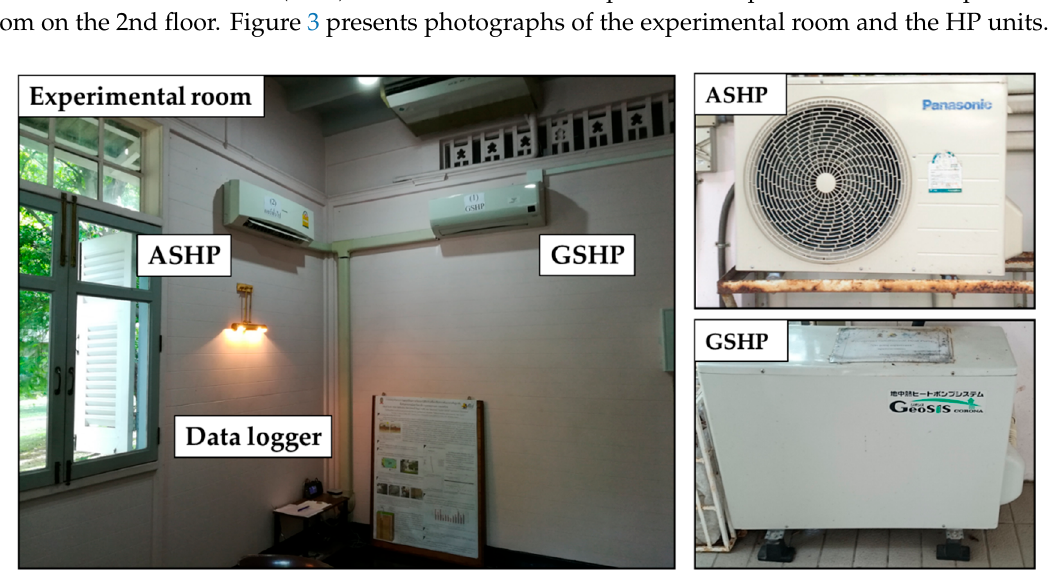
Figure 3. Photographs of the experimental room and the HP units.